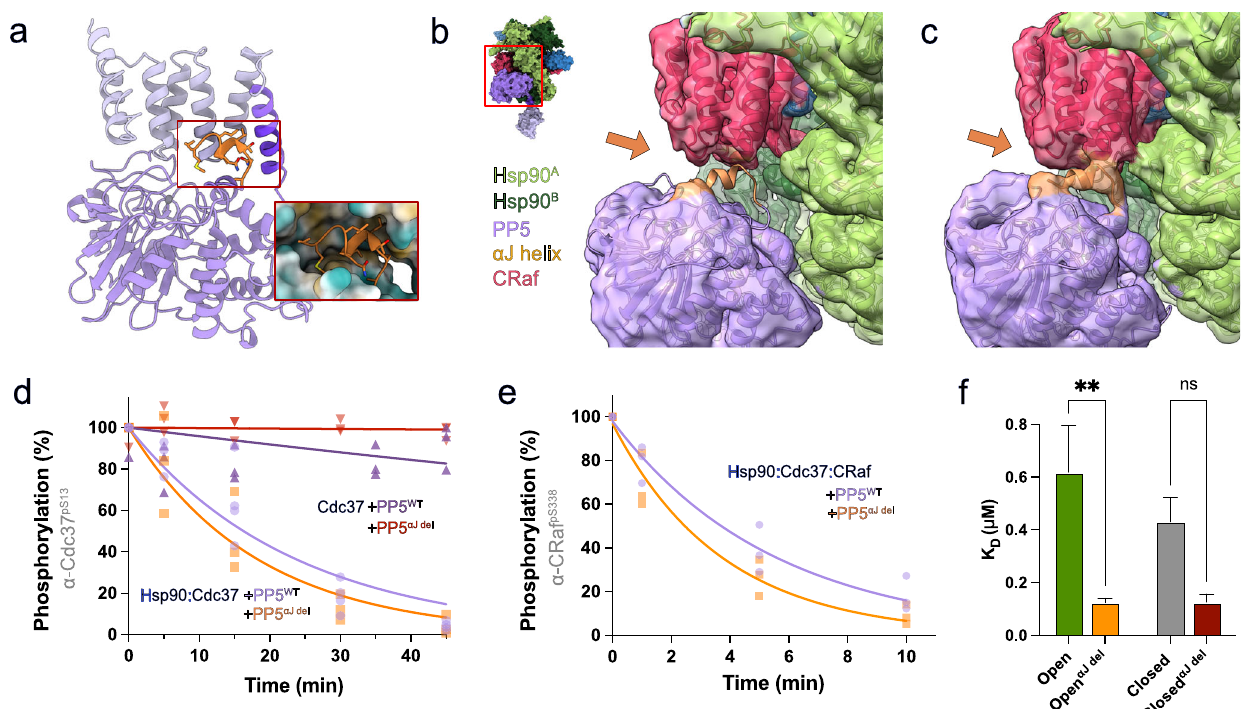
Fig. 5 | Deletion of PP5 ’ s α J helix increases rate of dephosphorylation. a In its inhibited conformation, the PP5 α J helix (orange) lies at the hydrophobic interface between the PP5 catalytic and TPR domains. b While initial focused classi fi cation around PP5 showed no α J helixdensity, c further classi fi cation showedpotential α J helix density near the PP5 catalytic domain. d PP5 α Jdel does not dephosphorylate Cdc37 without Hsp90 present (Rates ± S.E.M. reported (min − 1 ), 0.0±0.0), but PP5 α Jdel dephosphorylatesCdc37whileboundtoHsp90ataslightlyhigherratethan PP5 WT (0.055±0.007 vs 0.043±0.006). An ordinary one-way ANOVA found dif- ferences signi fi cant ( F =29.40, p <0.0001), while Dunnett ’ s multiple comparisons test showed signi fi cance between Hsp90-free complexes and Hsp90:PP5 WT com- plexes ( p <0.0001), but not between PP5 α Jdel and PP5 WT (0.055±0.007 and